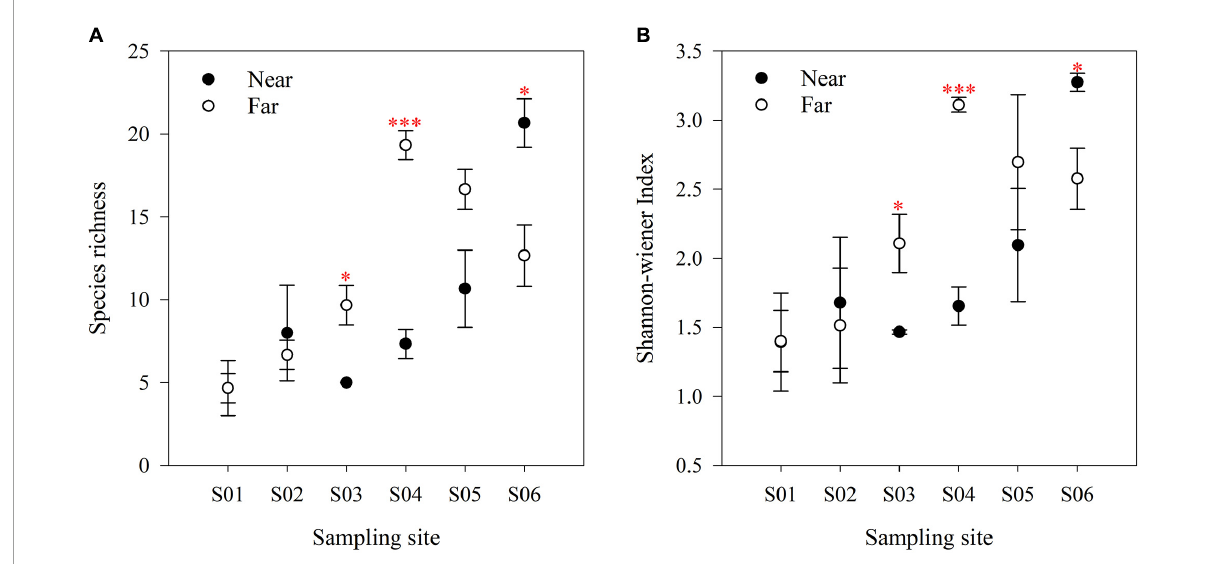
FIGURE5 AM fungal species richness (A) and Shannon-wiener index (B) in riparian zone. The data are means ± SE ( n = 3). Significant differences between the near-bank and the far-bank samples at the same sampling site were determined based on the Kruskal-Wallis Test (* P < 0. 05; ** P < 0.01; *** P < 0.001).